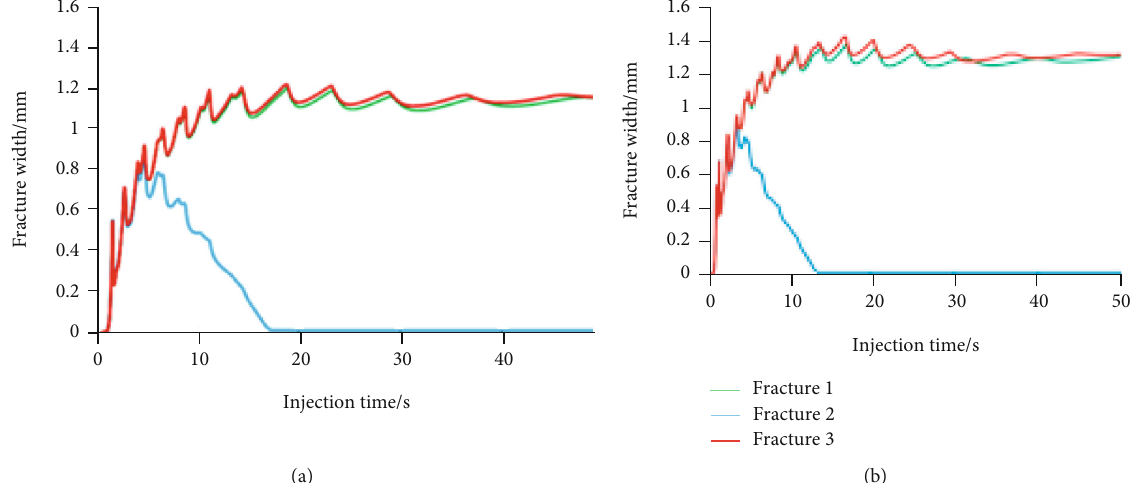
Figure 7: The maximum fracture width of each cluster as a function of time for di ff erent fl ow rates: (a) case 1 (6 m 3 /min); (b) case 2 (10 m 3 /min).